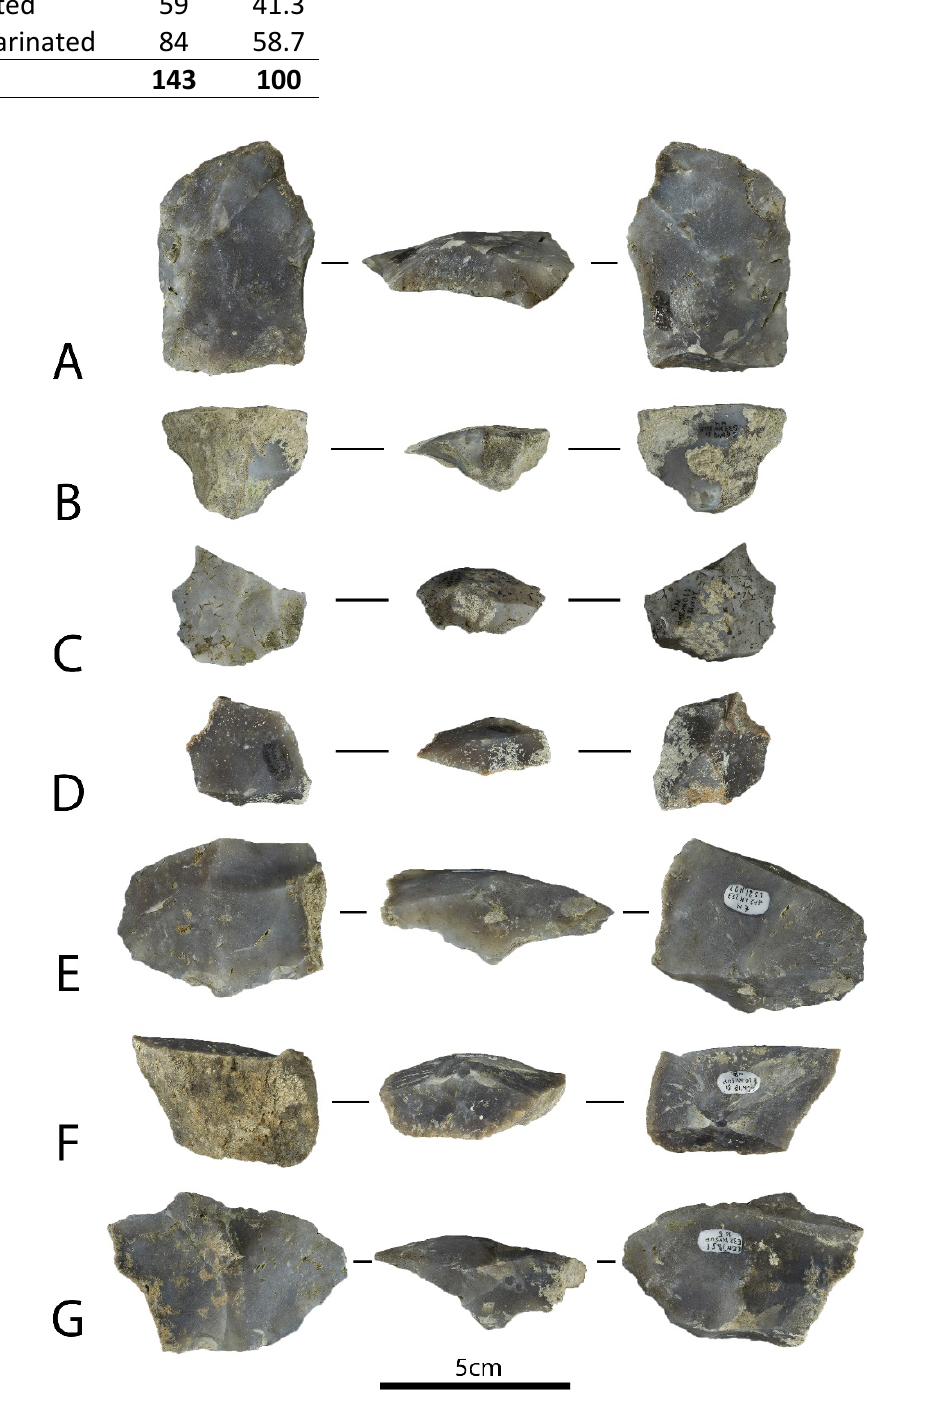
Figure 8. Some archaeological flakes and flake fragments with attributes that indicate the search for standardized forms and percussion with a hard hammer (iron). A) Large flake with a thick butt and a marked bulb (LGN’18_sup_D29_8). B) Flake fragment with distal transverse fracture (LGN’18_sup_G33_4). C) Flake fragment with an oblique fracture (LGN’18_sup_G30_4). D) Flake fragment with a distal transverse fracture (LGN’18_sup_I31_2). E) Flake fragment with a distal transverse fracture and with the point of impact very marked (LGN’18_sup_E32_7). F) Decorticate flake fragment with a distal transverse fracture, thick butt, marked bulb and point of impact (LGN’18_sup_E30_8). G) Flake fragment with a distal transverse fracture, thick butt and marked bulb (LGN’18_sup_E32_5) (Photographs by M. D.